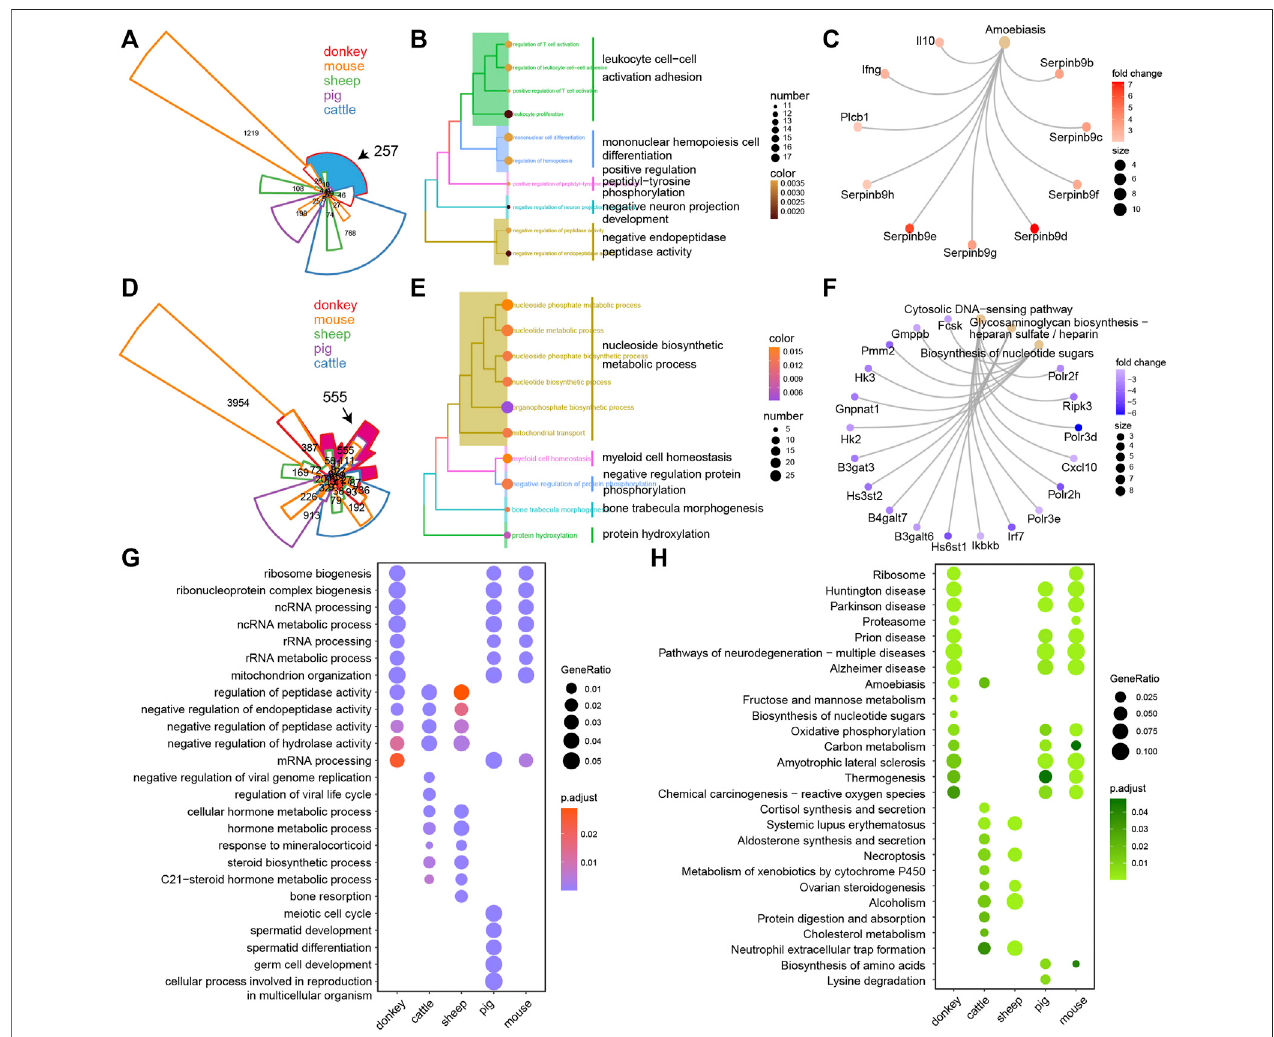
FIGURE 4 | The unique transcriptional characteristics of donkey oocyte development during the period from germinal vesicle (GV) to metaphase II (MII). (A) Venn plotoftheup-regulateddifferentiallyexpressedgenes(up-DEGs)indifferentspeciesduringGV – MII.Theblackarrowreferstothedonkey-speci fi cup-DEGscomparedto otherspecies.Theareasizerepresentsthenumberofgenes,andtheareamarkedinbluecontainsthedonkey-speci fi cup-DEGs. (B and C) TheGO(biologicalprocess) terms and KEGG annotationof donkey-speci fi cup-DEGs, respectively. (D) Venn plot ofthe down-DEGs indifferentspecies during GV – MII. The black arrow refers to the donkey-speci fi c down-DEGs compared to other species. The area size represents the number of genes, and the area marked in rose red indicates the donkey- speci fi cdown-DEGs. (E and F) TheGO(biologicalprocess)termsandKEGGannotationofthedonkey-speci fi cdown-DEGs,respectively. (G and H) Thedotplotshows the GO (biological process) terms and KEGG annotation of the DEGs of donkeys and other species from GV – MII, respectively.